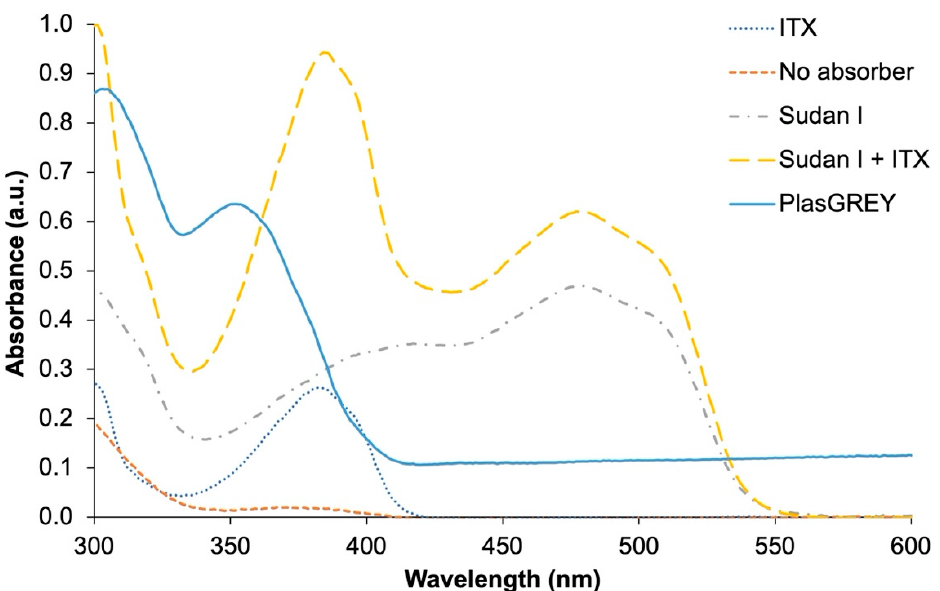
Figure 1. Absorbance spectra of various resin formulations compared with the commercially available PlasGREY resin. All custom resins have the same 0.8 w / w % of TPO-L and are made with RMS-083 polymer. Compositions of each formula can be found in Table S1.